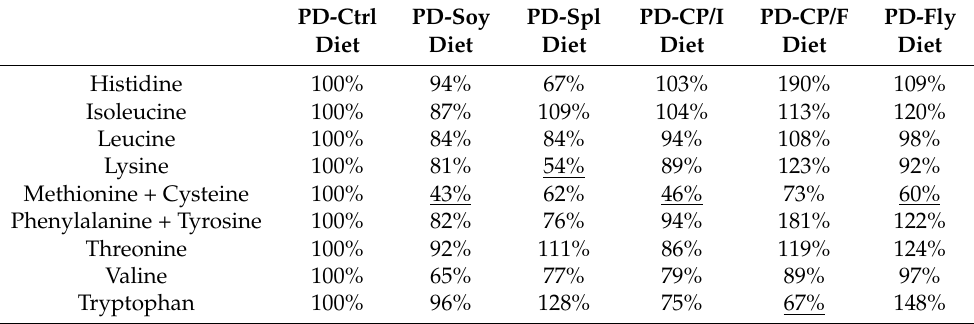
Table 5. Diets’ essential amino acids content as a percentage of PD-Ctrl diet’s amino acids profile. Part of the sulfuric amino acid methionine can be replaced by cysteine, and part of the aromatic amino acid phenylalanine can be replaced by tyrosine. The most limiting amino acid in every diet is underlined.